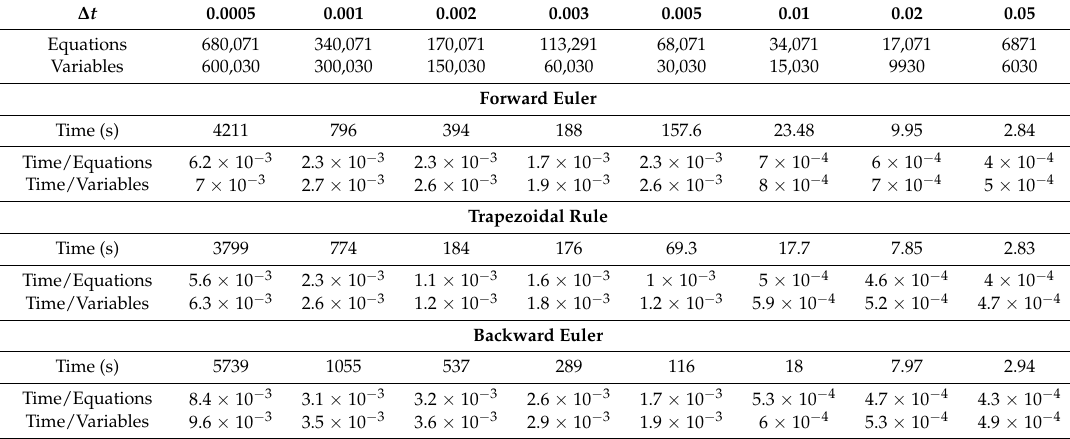
Table 2. Time of convergence of the TSCOPF for the studied numerical integration methods and different integration time